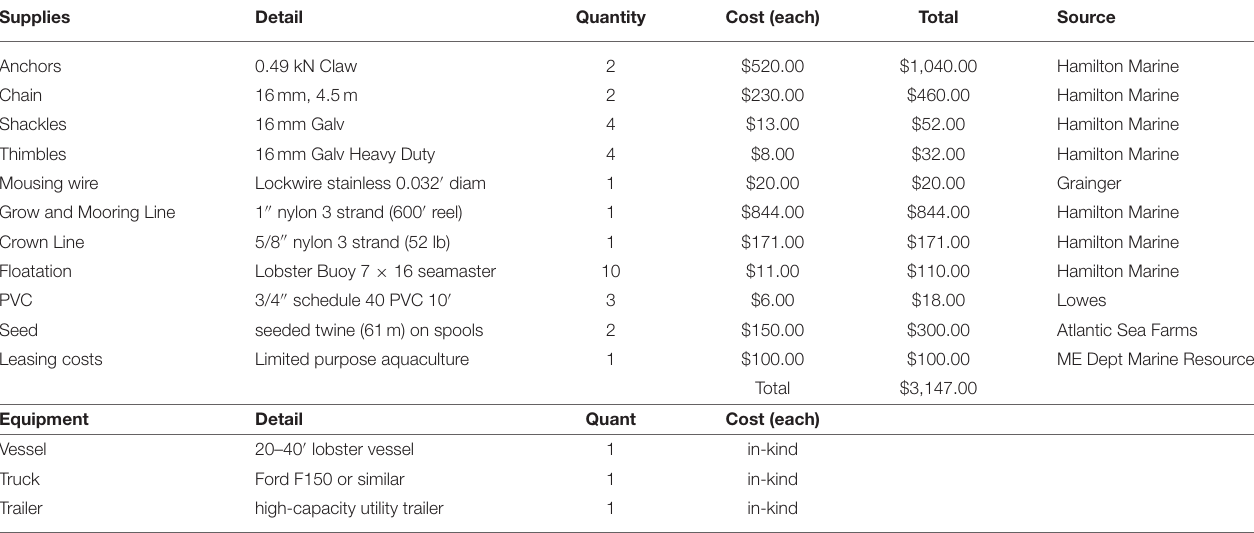
TABLE 3 | Itemized list of farm components and field operations equipment.